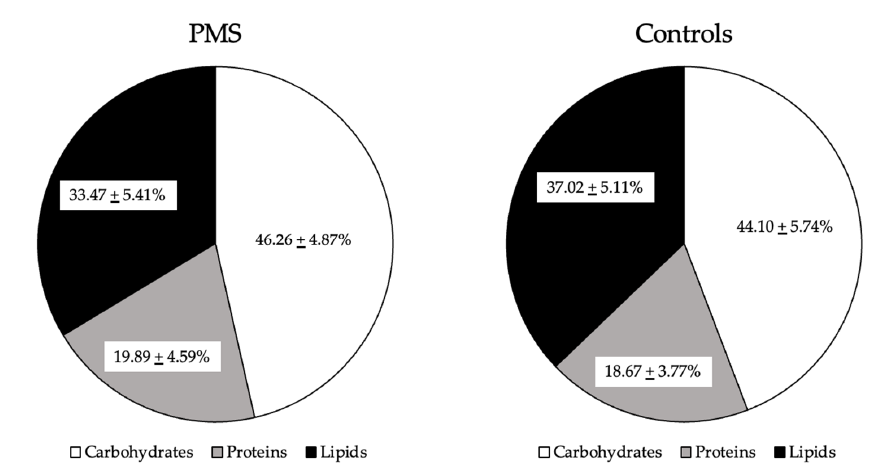
Figure 1. Macronutrient distribution ranges in the diets of participating women. The figure shows the estimated macronutrient distributions as percentages of total energy intake for the two study groups. The statistical differences were not significant. The macronutrient intake of PMS women followed the recommendation for the Italian population, while in the control group lipid consumption was slightly elevated and carbohydrate intake was slightly reduced compared to the optimal intakes (carbohydrates = 45–60%; proteins 15–25%; and lipids = 20–35%) [25]. In women with PMS, simple carbohydrates accounted for 12.82 ± 4.75% of total en- ergy intake and fiber intake was 12.58 ± 4.22 g per 1000 kcal. In CTRL subjects, simple carbohydrates accounted for 13.99 ± 2.12% of total energy and fiber intake was 11.06 ± 2.97 g per 1000 kcal. The differences were not statistically significant (Table 3). Table 3. Estimated daily carbohydrate intakes in the participating women. PMS Controls p Value Recommended [25] Total simple sugars